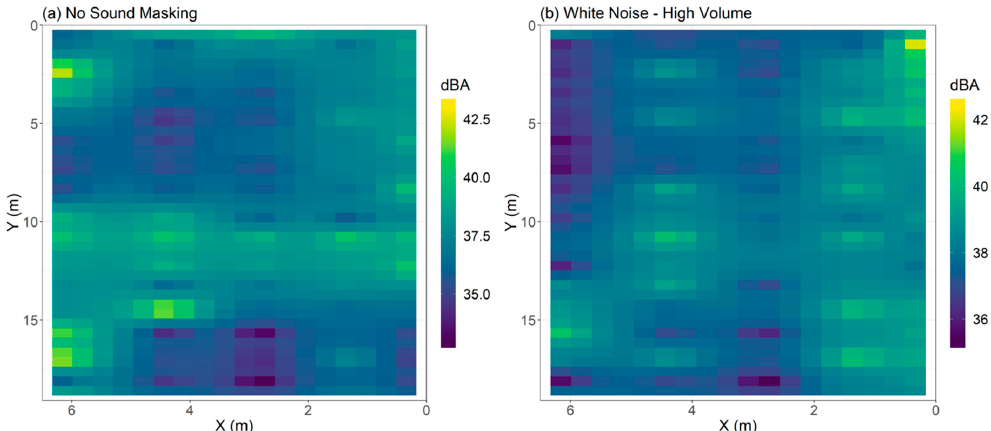
Figure 8. Spatial variability of sound levels (dBA) during the ( a ) no sound masking condition and the ( b ) high volume white noise condition during the multi-IEQ study.